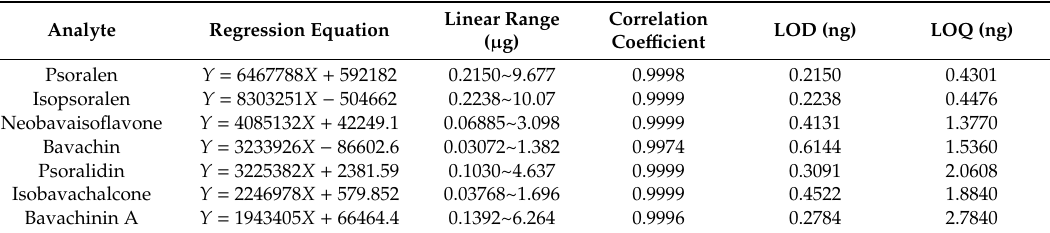
Table 6. Regression equations, linear ranges, limit of detection (LODs), and limit of quantification (LOQs) of the